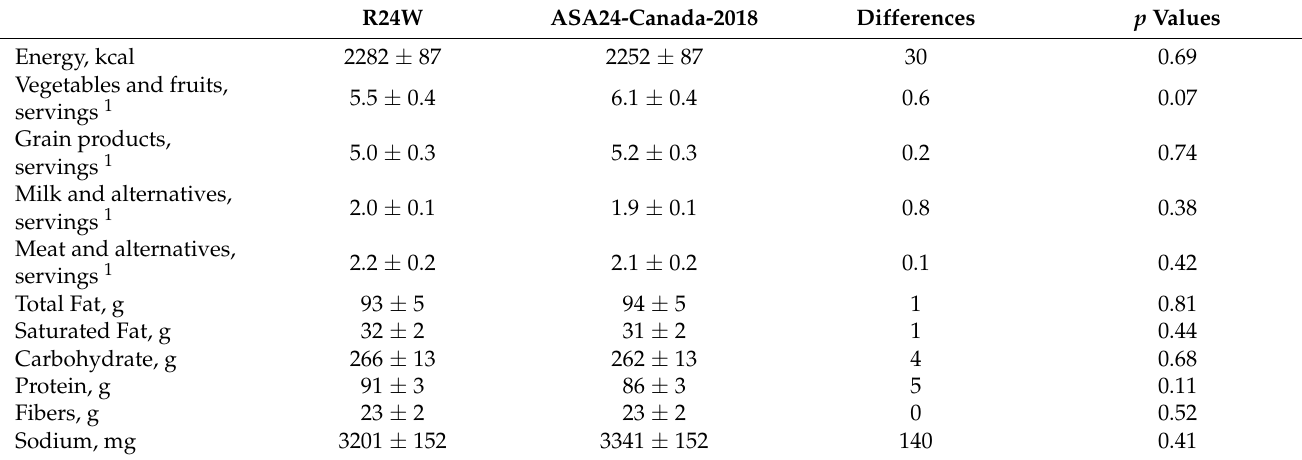
Table 5. Mean dietary intakes measured by the R24W and